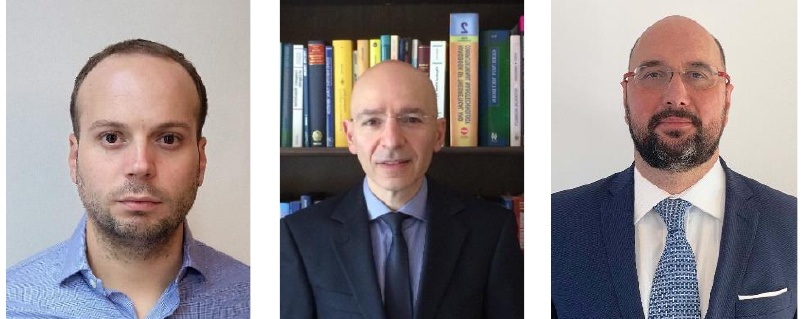
Figure 1. Michael Frank, Dimitris Drikakis, and Vaassilis Charissis (from left to right). Evaluation of a Near-Wall-Modeled Large Eddy Lattice Boltzmann Method for the Analysis of Complex Flows Relevant to IC Engines